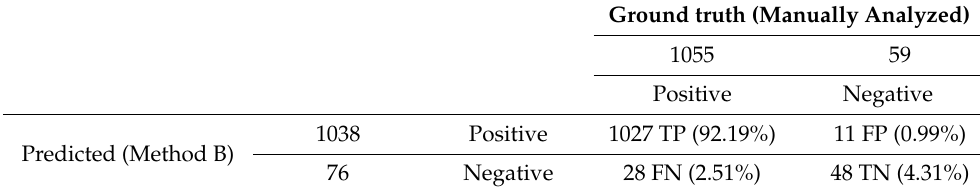
Table 3. Confusion matrix of results obtained by method B.